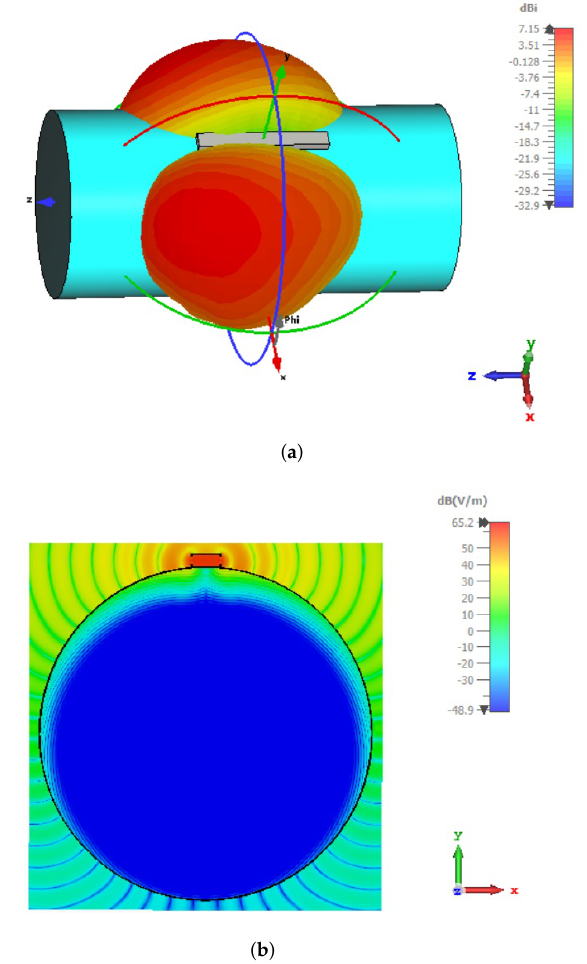
Figure 15. 3D radiation pattern ( a ) and moment-in-time snapshot of the E-field distribution in the plane perpendicular to the waveguide slots ( b ) of the waveguide array with one pair of slots shown in Figure 13b. The maximum of the E-field in the human phantom, and thus the maximum of SAR, is located next to the waveguide edge where the slots are